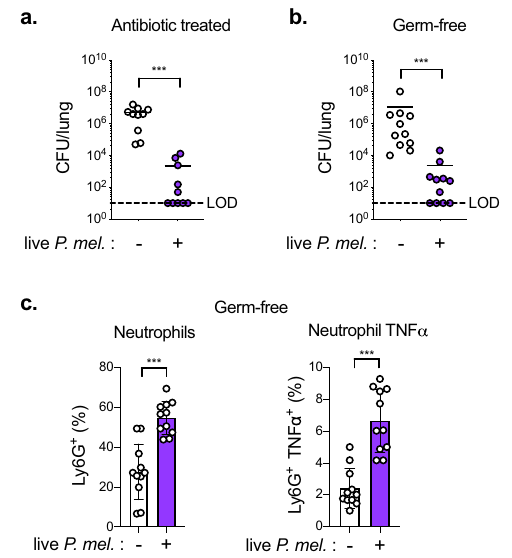
Fig. 4 P. melaninogenica ( P. mel .) is protective against S. pneumoniae infection in microbiome-depleted mice. a Lung S. pneumoniae burdens in mice treated with antibiotics followed by exposure to PBS (-) or live P. mel . strain 25845 i.t. prior to 24 h S. pneumoniae infection, 5 × 10 6 CFU/mouse ( n = 9 mice/group). b , c Lung S. pneumoniae burdens ( b ) and percent neutrophils, neutrophil TNF α ( c ) in Germ-free mice treated with either PBS (-) or live P. mel . i.t. prior to 24 h S. pneumoniae infection, 10 6 CFU/mouse ( n = 11 mice/group). LOD = limit of detection. Data are pooled from three independent experiments. Data are displayed as mean ± SEM. For a , b *** p < 0.0001 two-tailed Mann – Whitney U -test, c *** p < 0.0001 two- tailed t -test. Source data are provided as a Source Data fi